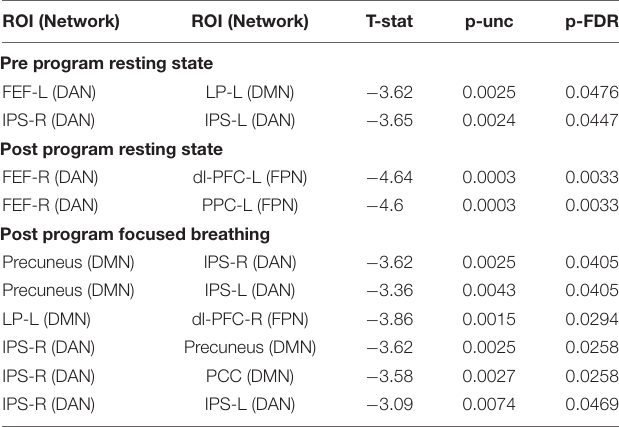
TABLE 3 | Comparison between meditators and controls for functional connectivity at both time points and